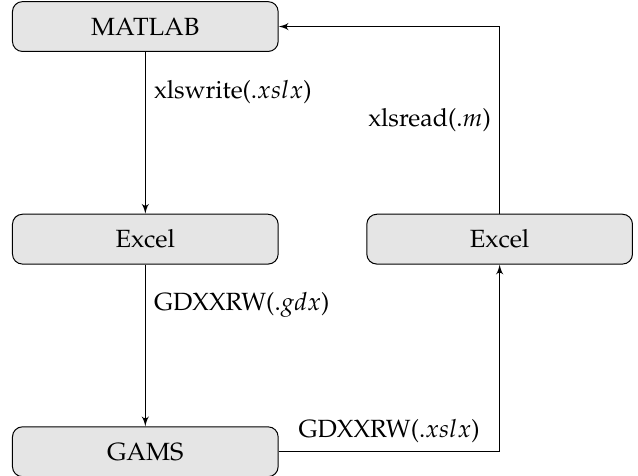
Figure 1. Diagram of the information exchange in the MATLAB–GAMS